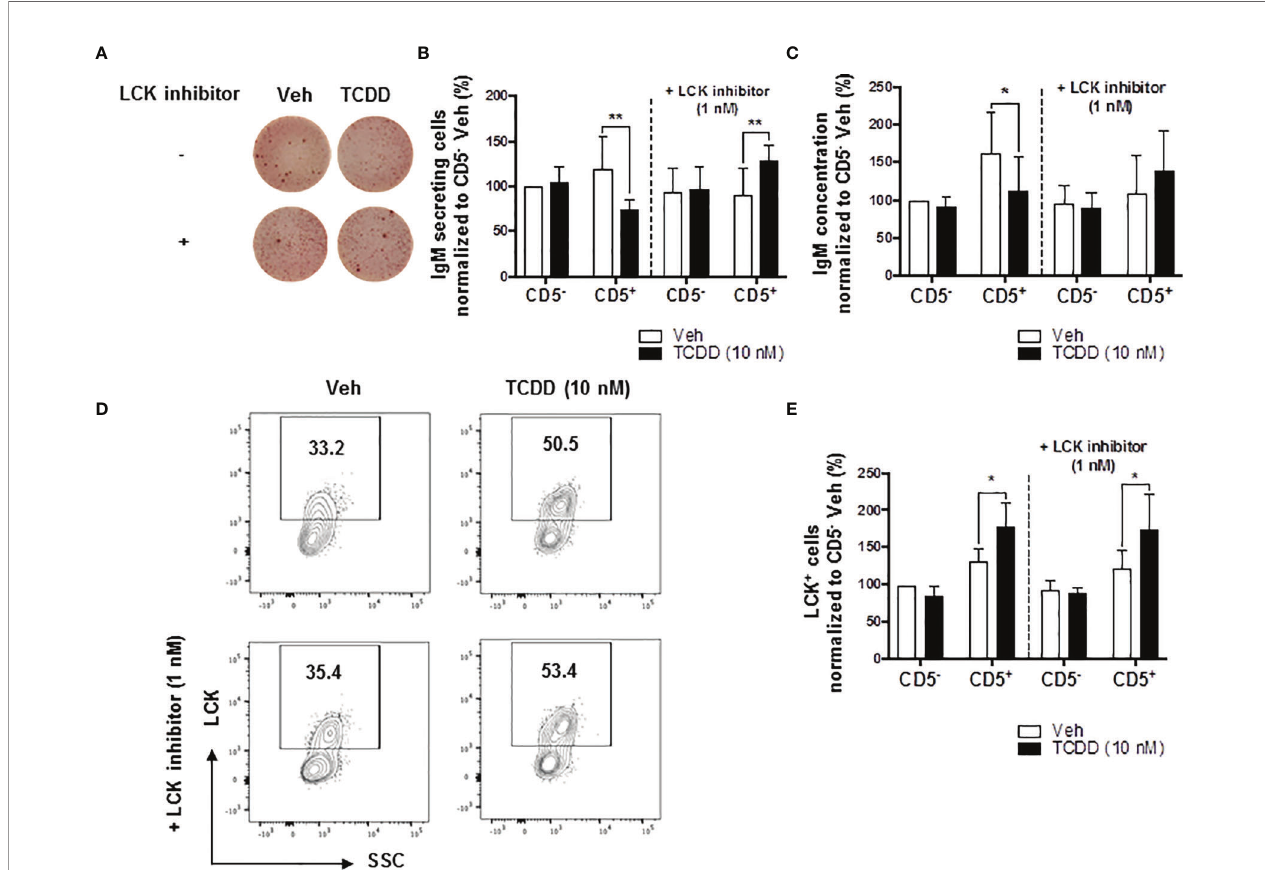
FIGURE 3 | LCK inhibitor treatment reversed the AHR-mediated suppression of the IgM response in CD5 + ILBs. Human CD5 +/- B cells were activated and treated with Veh or TCDD on day 0 and cultured for 7 days as described previously. LCK inhibitor (RK24466) was added on day 5 to the cell culture. (A) Representative ELIspot wells showing IgM secreting cells measured within CD5 +/- B populations on day 7; (B) Averaged number of IgM secreting cells and; (C) Averaged IgM concentration within culture supernatants collected from Veh or TCDD-treated CD5+/- cultures with and without LCK inhibitor; (D) Representative fl ow cytometry plots of LCK + CD5 + ILBs with or without LCK inhibitor treatment; and (E) Averaged percentage of LCK + cells within CD5 +/- populations with or without LCK inhibitor treatment. Determinations were made using B cells from 6 human donors (N = 6) from two independent experiments. Data presented in the fi gures were normalized to the CD5 - Veh without LCK inhibitor treatment. Signi fi cant differences are indicated by * p < 0.05 and ** p < 0.01 (two-way ANOVA following with Fisher ’ s LSD post hoc